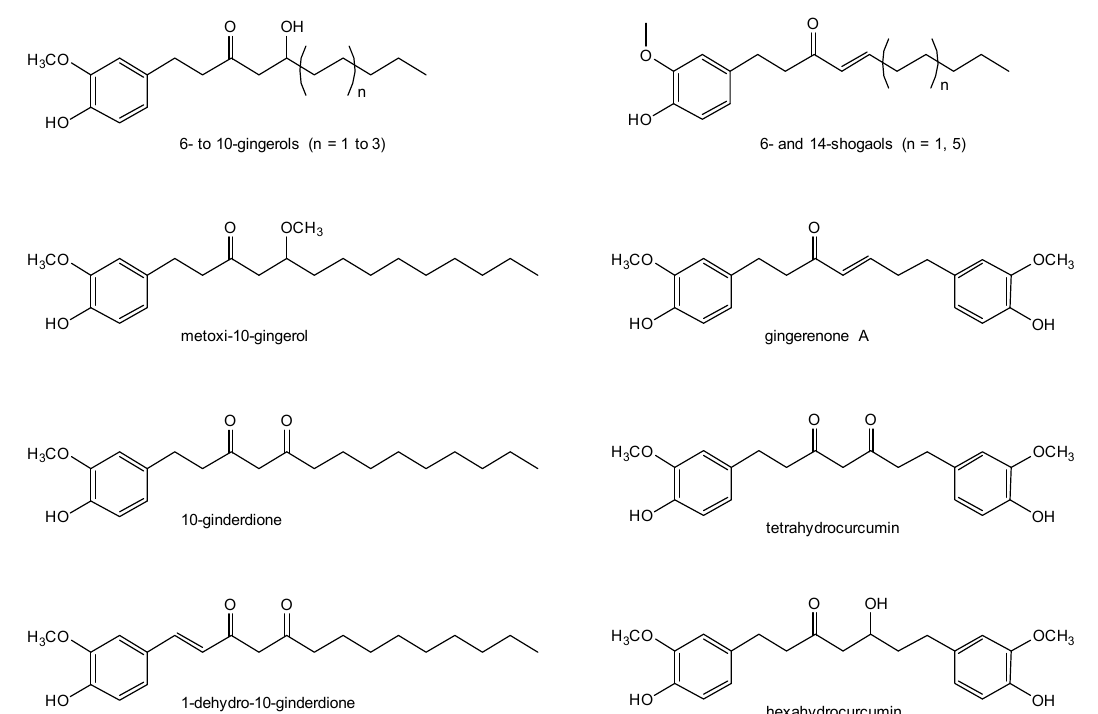
Figure 1. Structural representation of the most relevant bioactive compounds occurring in ginger.